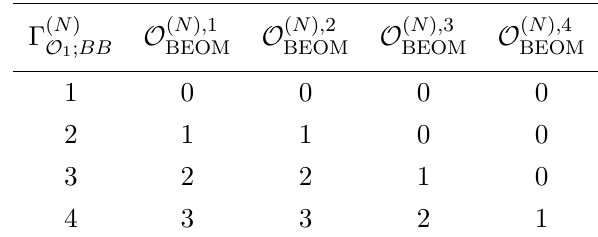
Table 5 . The table summarizes the loop orders for which the mixing of O ( N ) given a certain loop order of Γ ( N )